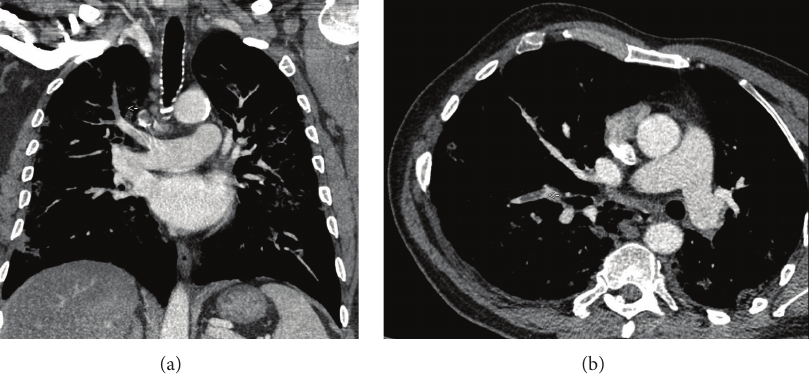
Figure 1: Pulmonary thromboembolism (arrow).